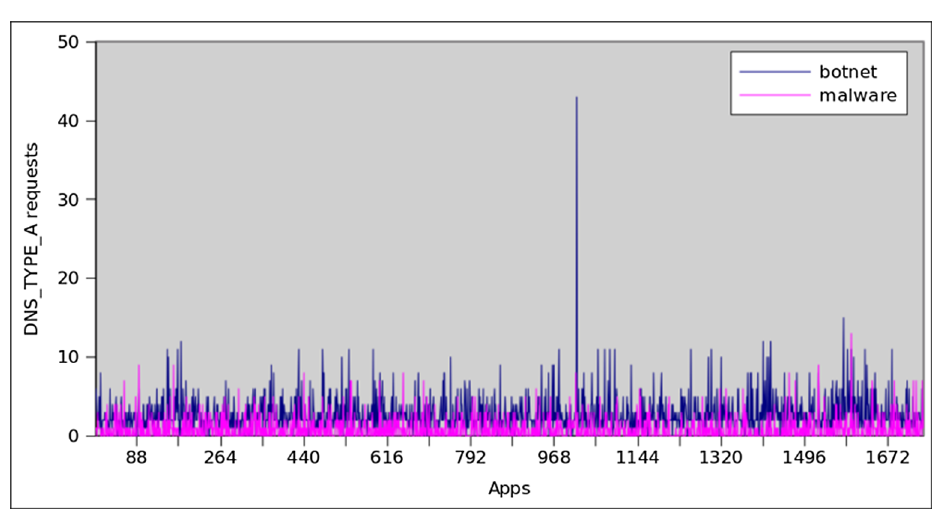
Fig 14. DNS_TYPE_A record comparison.